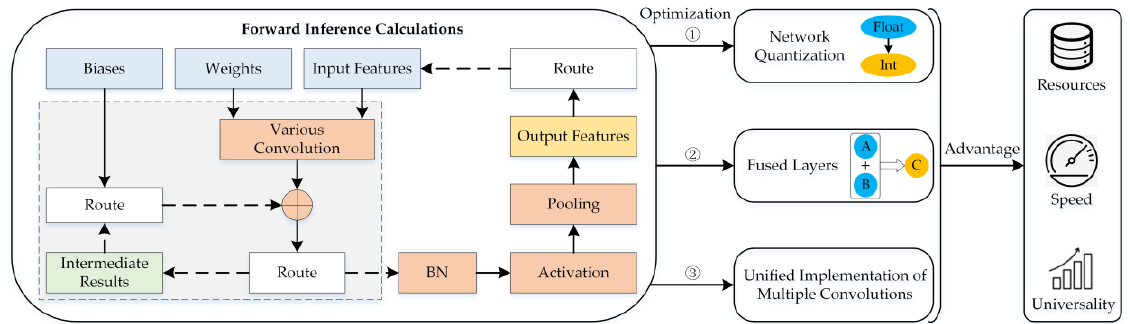
Figure 4. The forward inference calculation process of the fundamental network and an overview of our optimization for implementation.